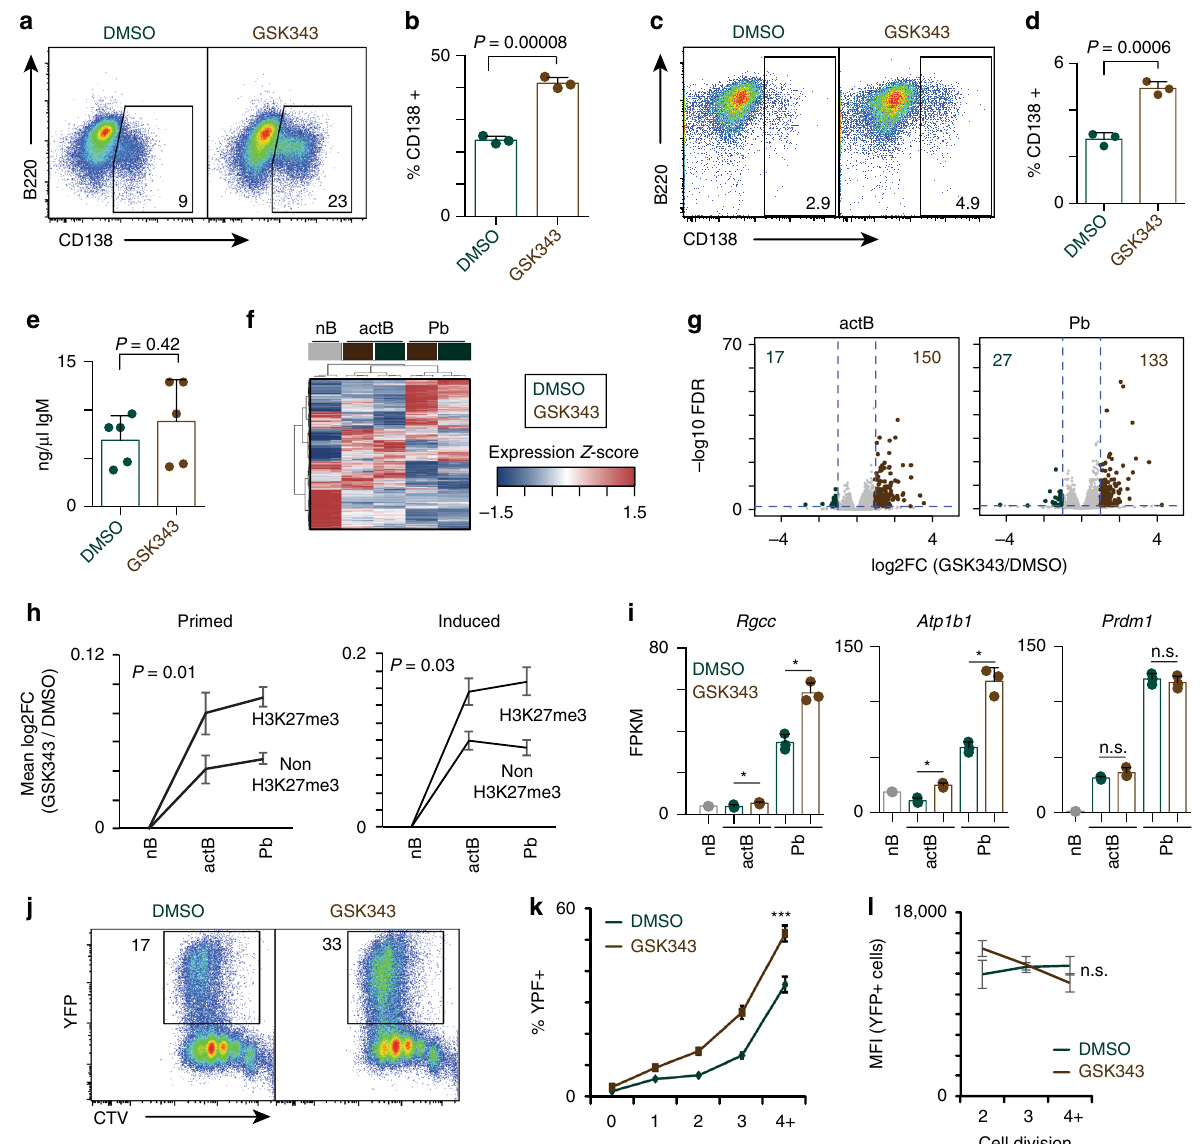
Fig. 7 Inhibition of EZH2 results in enhanced plasma cell differentiation. a Representative fl ow cytometry analysis of B220 versus CD138 expression following ex vivo culture with LPS, IL2, and IL5 for three days + / − GSK343. b Quanti fi cation of data from a . c Representative fl ow cytometry analysis of B220 versus CD138 expression following ex vivo culture with CD40L, IL4, and IL5 for three days + / − GSK343. d Quanti fi cation of data from c . e Secretion rate of IgM/hr for plasma cells cultured from a . f Hierarchical clustering of samples and DEG between GSK343 treated actB and Pb. g Volcano plot of RNA- seq data quantitating changes in gene expression following GSK343 treatment comparing actB cells (B220 + GL7 + CD138 − ) (left) and Pb (CD138 + ) (right). Genes signi fi cantly up or down regulated are color-coded. h For primed and induced genes, the mean log2 fold change (FC) for genes marked versus not marked by H3K27me3 is plotted. Signi fi cance between datasets was determined by two-way ANOVA. i RNA-seq expression data for the indicated genes for each cell type. FPKM, fragments per kilobase per million. Asterisk (*) indicates signi fi cant differential expression as determined by edgeR. j Representative fl ow cytometry of cell trace violet (CTV) labeled Blimp-1-YFP B cells after three days culture with LPS, IL-2, and IL-5 in the presence of DMSO or GSK343. The percentage of YFP + cells are indicated. k YFP + cells from j are quantitated at each division. Signi fi cance determined by